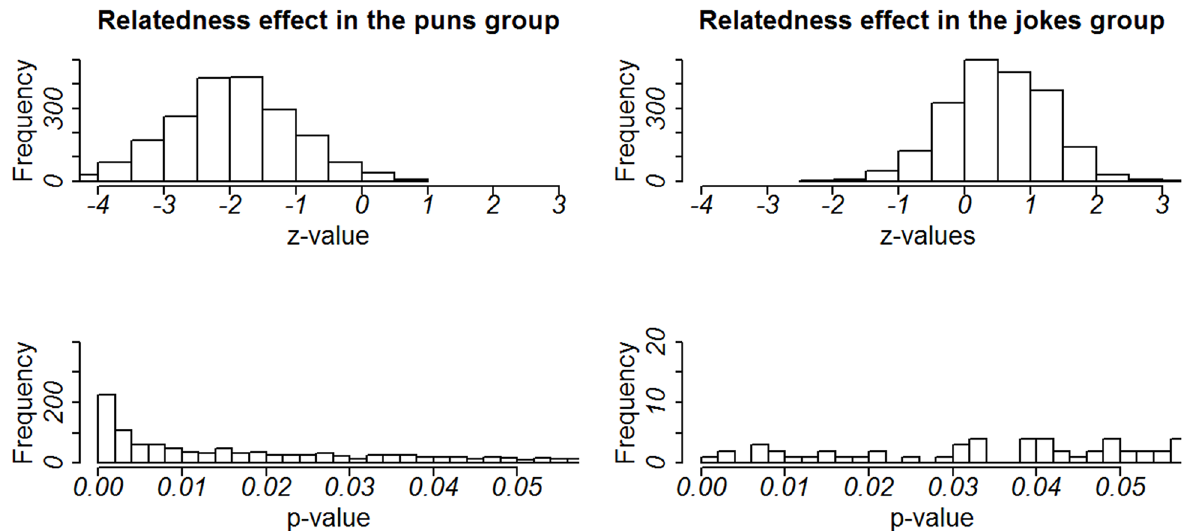
Fig 5. Results of the bootstrap approach: frequency distributions of z-values and p-values for the planned comparisons between related and unrelated distractors in the puns and jokes group.